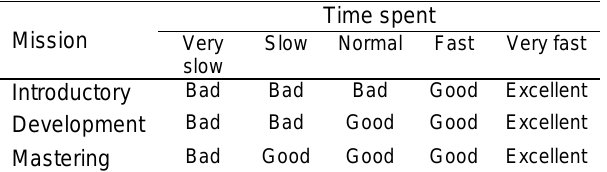
Table 2. Fuzzy rule-base.